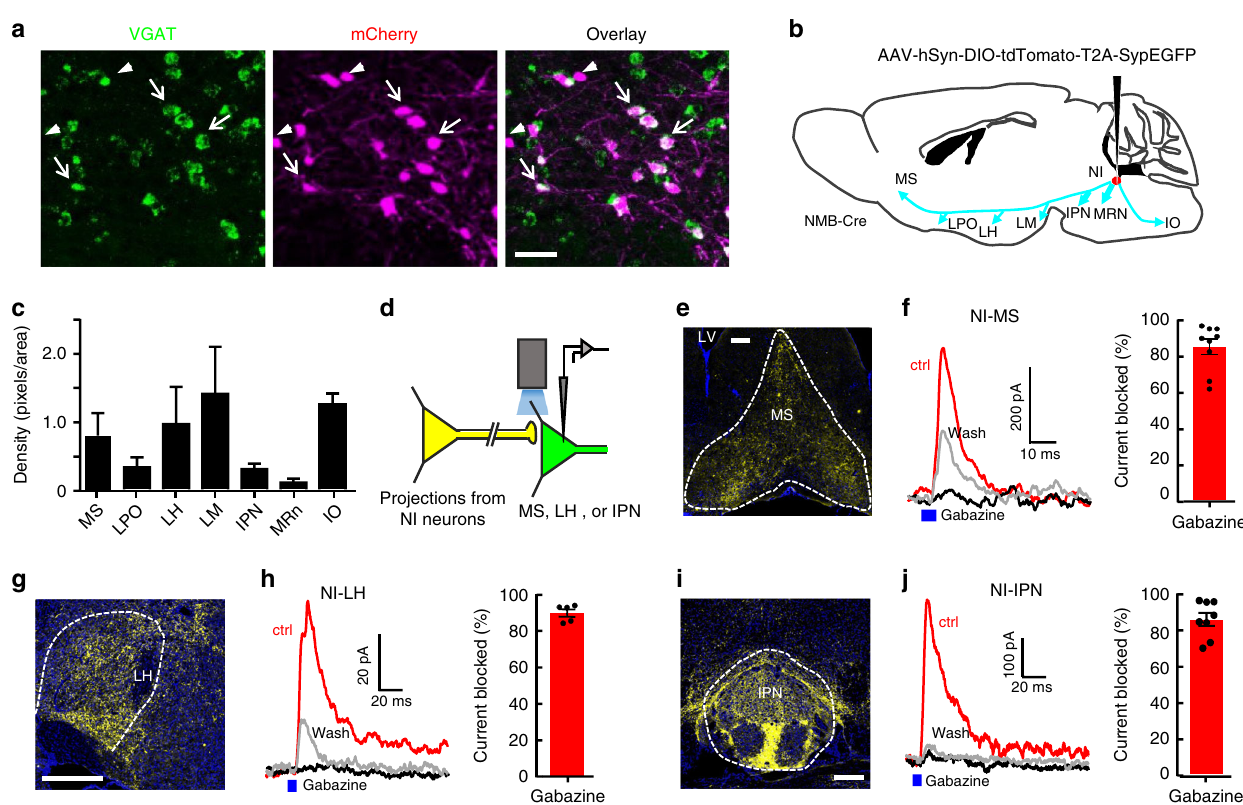
Fig. 6 NI NMB neurons project to multiple brain areas. a The presence of VGAT ( slc32a1 ) mRNA (green) in mCherry-expressing NI NMB neurons ( n = 937 VAGT + /1234 mCherry + neurons; 937 mCherry + /2089 VGAT + neurons; 20 sections from 4 mice). Arrows, dual labeled cells; Arrowheads, mCherry + cells that clearly lacked VGAT mRNA expression. b Schematic shows that expressing synaptophysin-EGFP in NI NMB neurons labels terminals in several subcortical structures. c The normalized density of innervations (total EGFP + pixels divided by the area of each nucleus; n = 4 mice). d Schematic diagram showing the method of optogenetic stimulation and recordings from the MS, the LH or the IPN in brain slices. e, f Terminal expression of synaptophysin-EGFP in the MS ( e ) and the effect of activating ChR2-expressing terminals on evoking IPSCs from MS neurons ( f ). The left panel in ( f ) shows representative traces of light-evoked IPSCs from an MS neuron before (red; latency, 4.8 ± 1.1 ms), during (black), and after (gray) Gabazine application. The right panel shows the group data on the effect of Gabazine on blocking the light-evoked IPSCs ( n = 9 cells from 4 mice). Postsynaptic current was measured holding at − 10 mV. g , h Terminal projection pattern of NI NMB neurons in the LH ( g ) and the effects of activating NI NMB neurons on evoking IPSCs from LH neurons ( h ; latency, 3.9 ± 1.8 ms; n = 5 cells in 5 mice). i , j Distribution of NI NMB axonal terminals in the IPN ( i ) and the effects of activating the terminals on the Gabazine-sensitive IPSCs of IPN neurons ( j ; latency, 6.1 ± 0.5 ms; n = 8 cells from 5 mice). Error bars ( c , f , h , j ) indicate SEM. Scale bars = 50 µ m ( a ), 200 µ m ( e , g , i ). Source data are provided as a Source Data fi